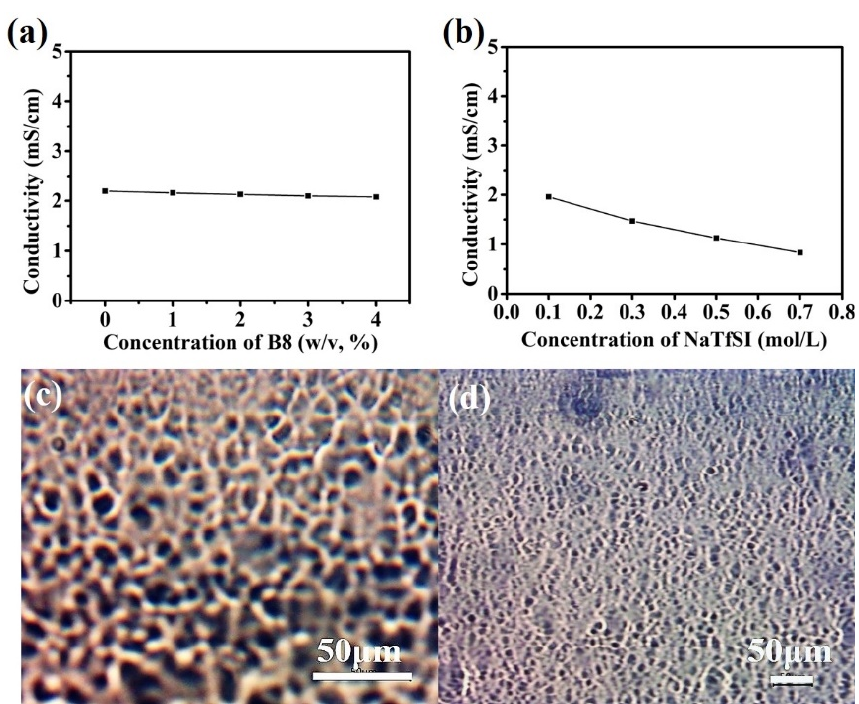
(SEM) images of xerogels (Figure S3), the abovementioned gels were also characterized by a reticular network, and the micropores of the xerogel of B8-BMPTFSI-NaTFSI gel were smaller than those of the B8-BMPTFSI gel. Smaller micropores were not favorable for ion movement, leading to the decrease in conductivity [47]. In conclusion, the addition of NaTFSI leads to a denser microstructure than the original gel [48], leading to the decreased conductivity of the gel electrolyte.